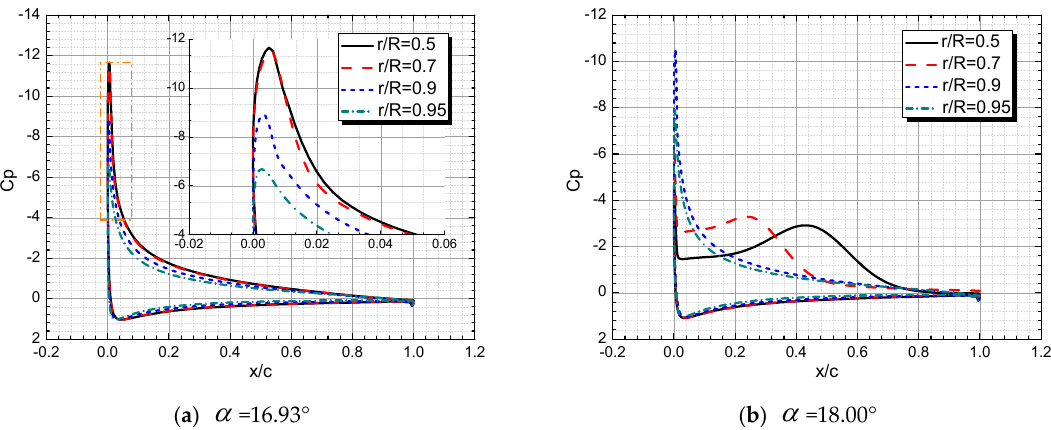
Figure 7. Cp distribution at different wing sections.